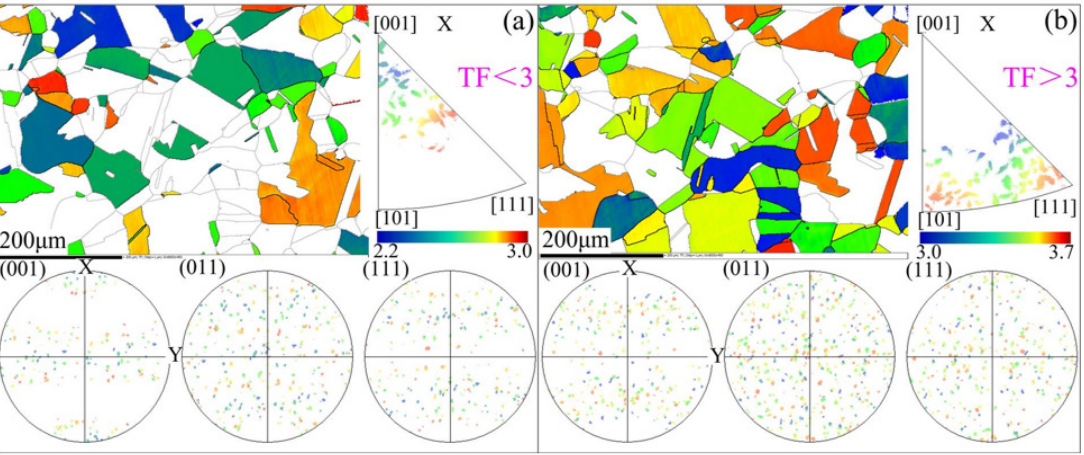
Figure 10. Taylor factor distribution map; corresponding pole figures and inverse pole figures of sample ϕ 2-Bi-10-1: ( a ) TF < 3 and ( b ) TF >